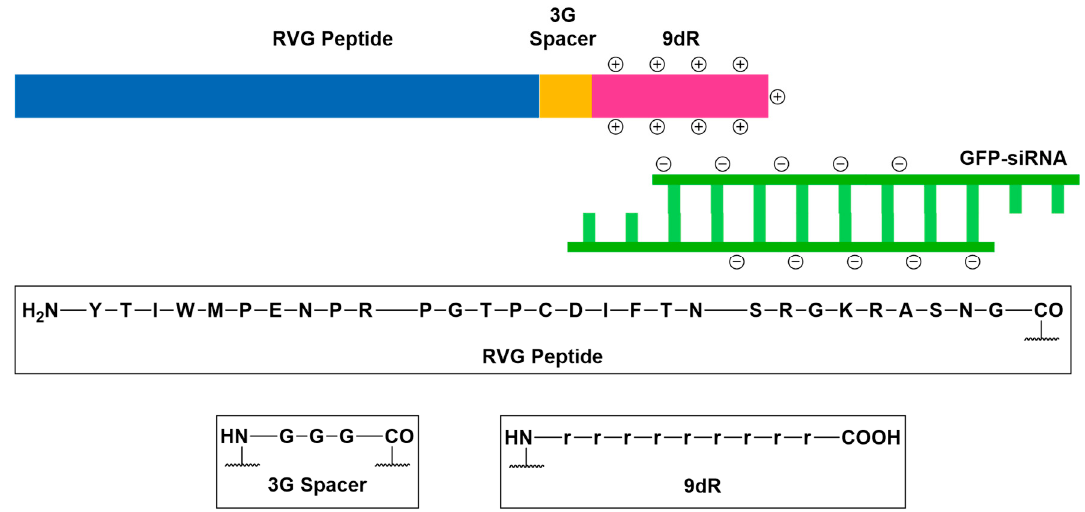
Figure 18. Schematic representation of the structure of rabies virus glycoprotein-derived peptide (RVG) in complex with GFP-siRNA. The conjugate was engineered to deliver GFP-siRNA to the brain by exploiting nicotinic acetylcholine receptor-mediated transcytosis. To enable the complexation of RVG to GFP-siRNA, RVG was coupled to a nona- D -arginine peptide (9dR) through a tri- L -glycine spacer.